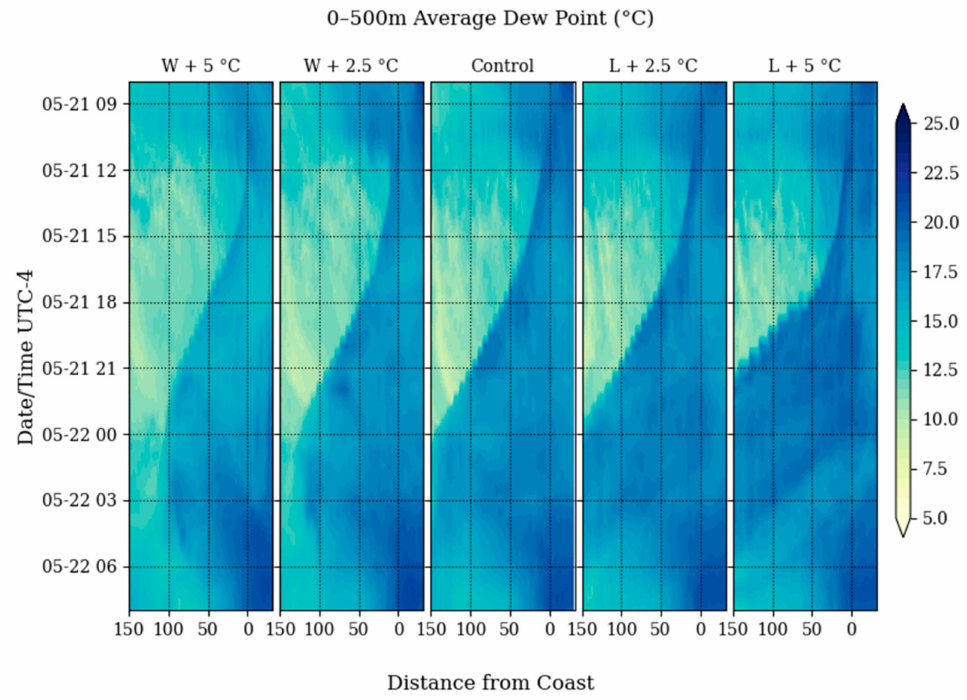
Figure 8. Average Dew point over the lowest 500 m above the ground as a time series over a 24-h period from 21 May 2019 to 22 May 2019. SRS is located 150 km from the coast (left